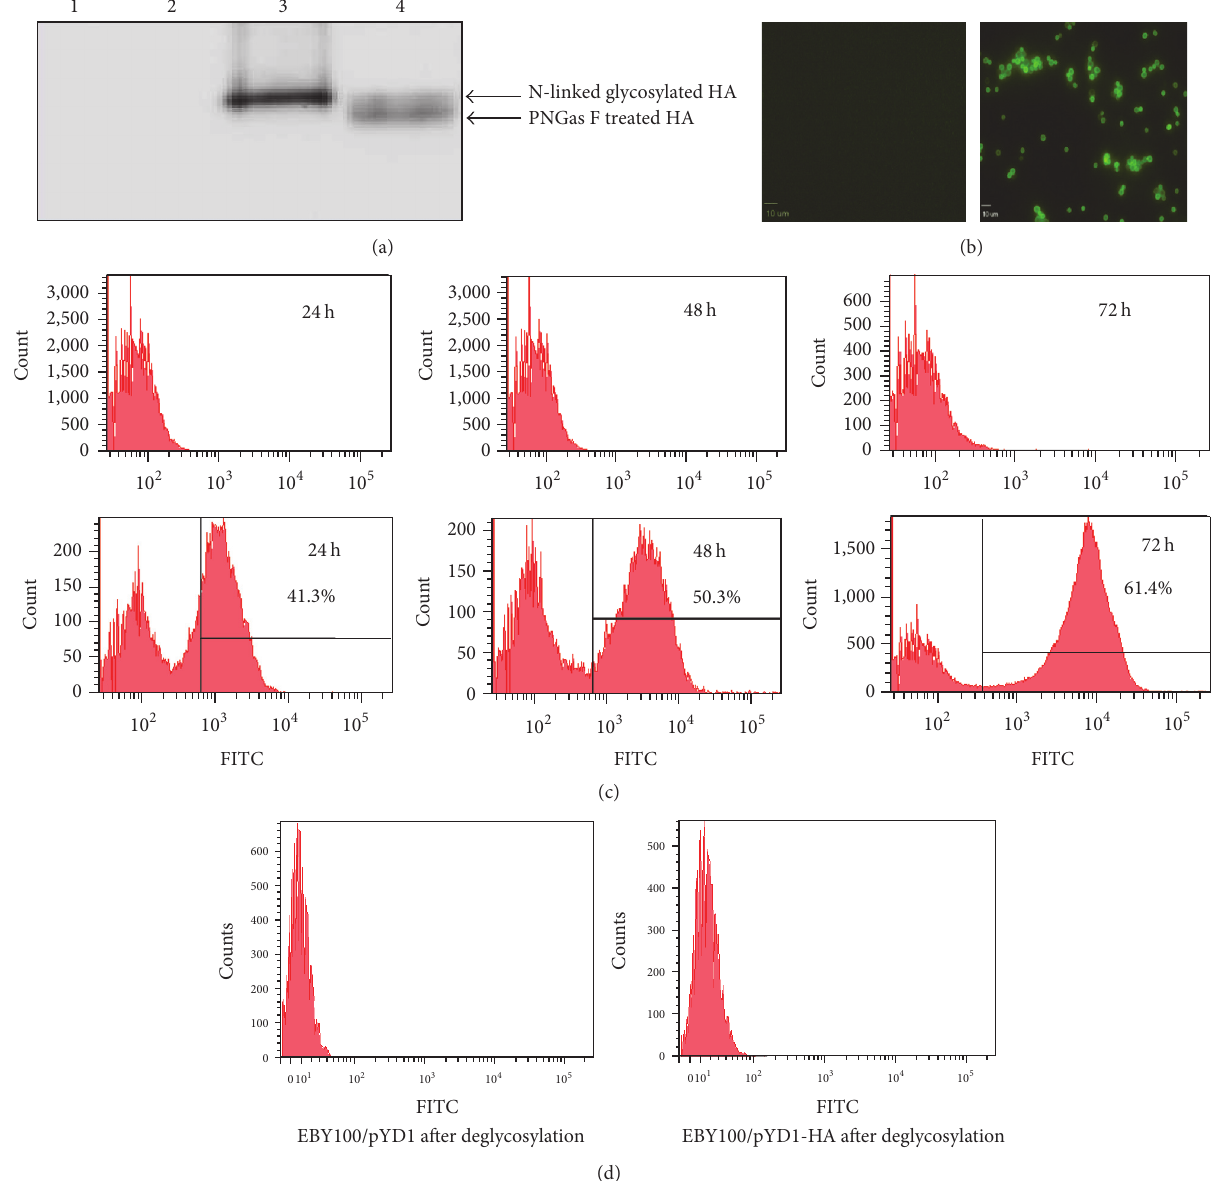
Figure 2: HA displayed on yeast surface. (a) Western blot of yeast surface-displayed HA. Lane 1: EBY100/pYD1 transformed yeast, Lane 2: PNGase F treated EBY100/pYD1 transformed yeast, Lane 3: EBY100/pYD1-HA transformed yeast, and Lane 4: PNGase F treated EBY100/pYD1-HA transformed yeast. (b) Immunofluorescence microscopy of EBY100/pYD1 (left) and EBY100/pYD1-HA (right) yeast at 72 h after induction. Scale bar: 10 𝜇 m. Yeast surface-displayed HA was immunostained with mouse anti-HA antibodies and goat anti-mouse IgG-FITC conjugates antibodies. (c) Flow cytometric analysis of HA displayed on yeast surface at 24, 48, and 72 h after induction. Top panel: EBY100/pYD1; bottom panel: EBY100/pYD1-HA. Yeast surface-displayed HA was immunostained with mouse anti-HA antibodies and goat anti-mouse IgG-FITC conjugates antibodies. (d) Flow cytometric analyses of EBY100/pYD1 and EBY100/pYD1-HA after